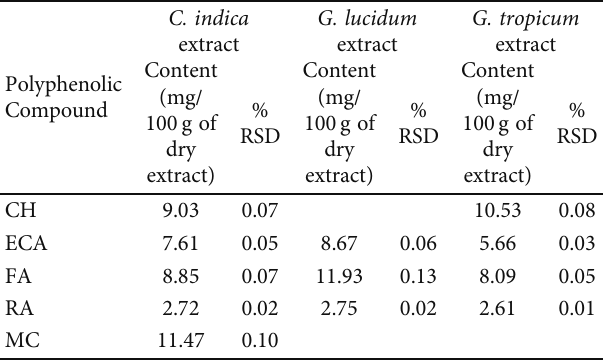
Figure 1: HPLC chromatogram of CI, GL, and GT extract. CI extract: Peaks: 1, (+)-catechin (CH); 2, (-)-epicatechin (ECA); 3, trans -ferulic acid (FA); 4, rosmarinic acid (RA). GL extract: Peaks: 1, (-)-epicatechin (ECA); 2, trans -ferulic acid (FA); 3, rosmarinic acid (RA). GT extract: Peaks: 1, (+)-catechin (CH); 2, (-)-epicatechin (ECA); 3, trans -ferulic acid (FA); 4, rosmarinic acid (RA). Table 3: Contents of polyphenolic compounds in the three mushroom extracts ( n = 5 ).